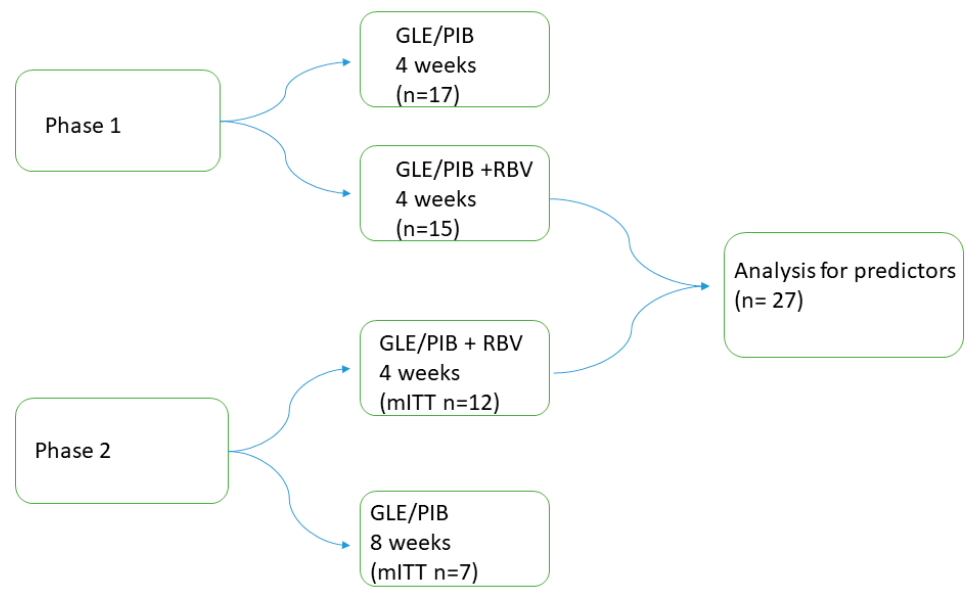
Figure 1. The 4RIBC study design of included patients. Abbreviations: glecaprevir/pibrentasvir (GLE/PIB); ribavirin (RBV); modified intention to treat (mITT).